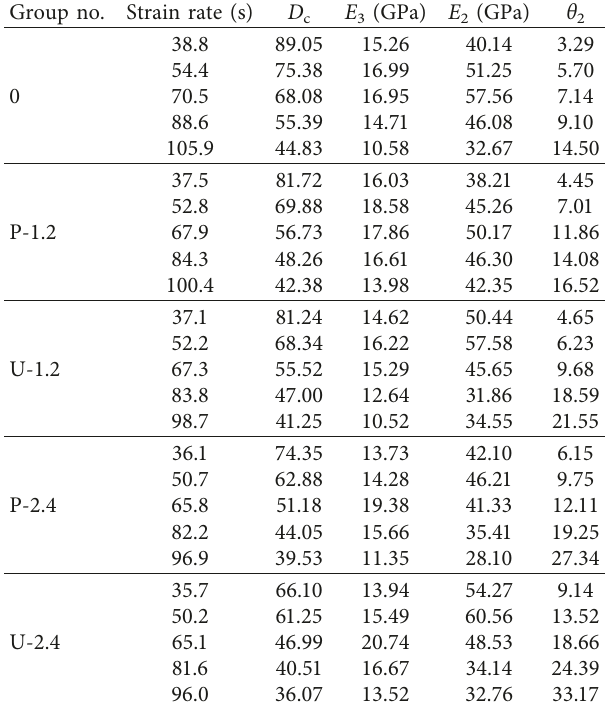
Table 5: Parameter results of each group of concrete constitutive models. Group no. Strain rate